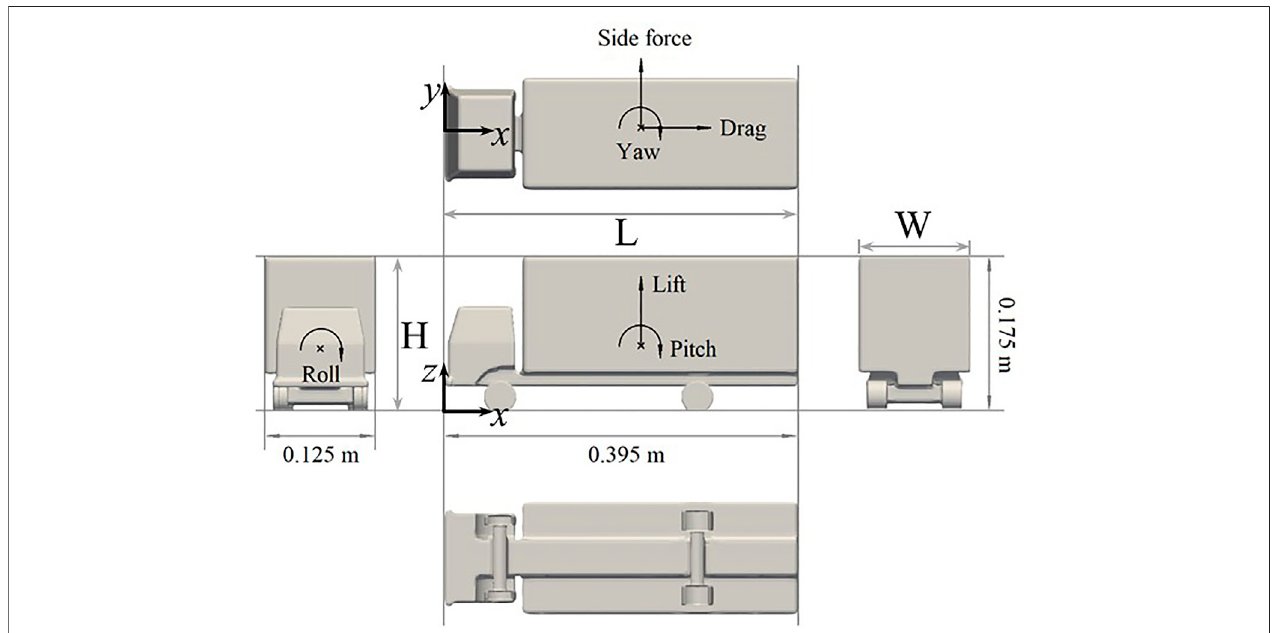
FIGURE 1 | Orthogonal views of the simpli fi ed lorry geometry with de fi nitions of the aerodynamic force and moment coef fi cients.